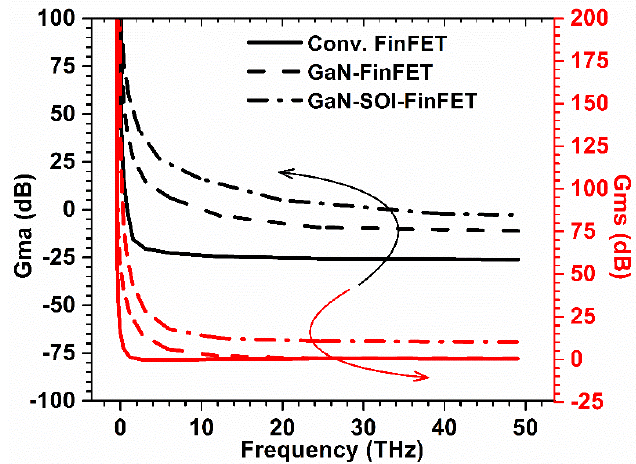
Figure 4. Gma and Gms for Conventional and GaN-SOI-FinFET.